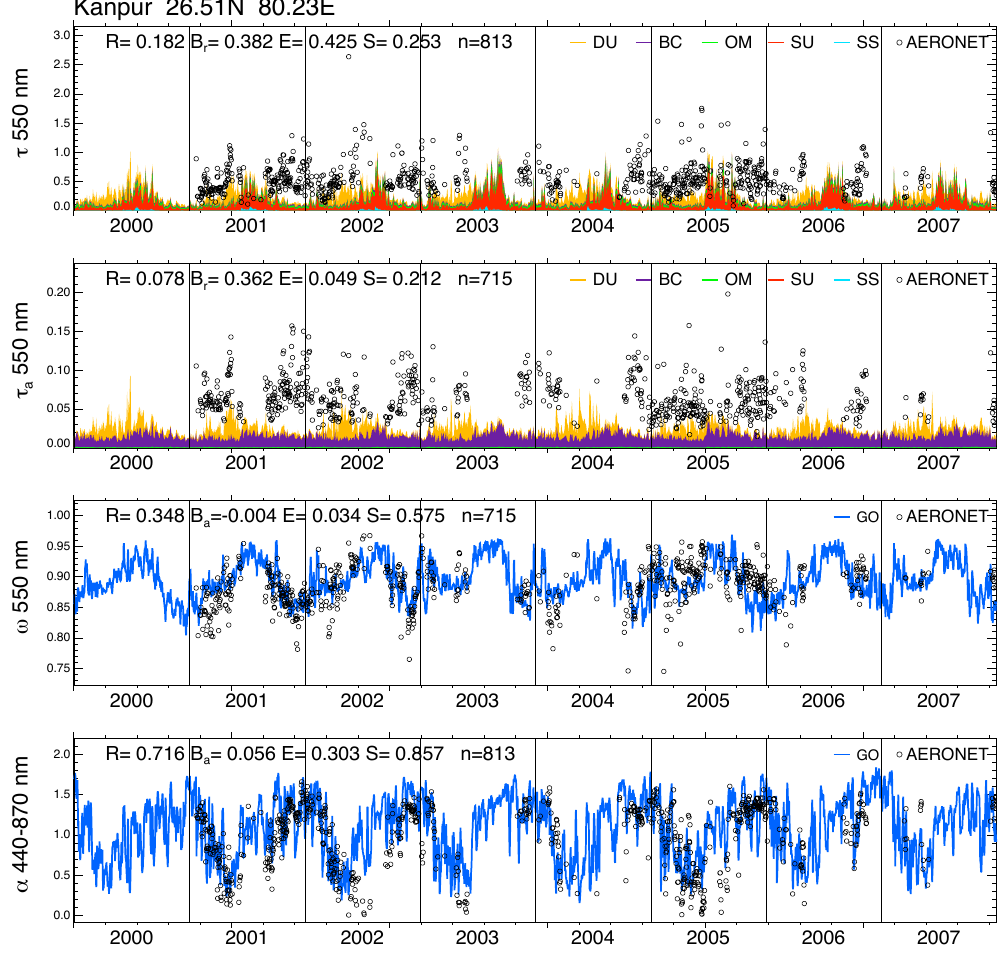
Fig. 5c. Same as Fig. 5a but for Kanpur,